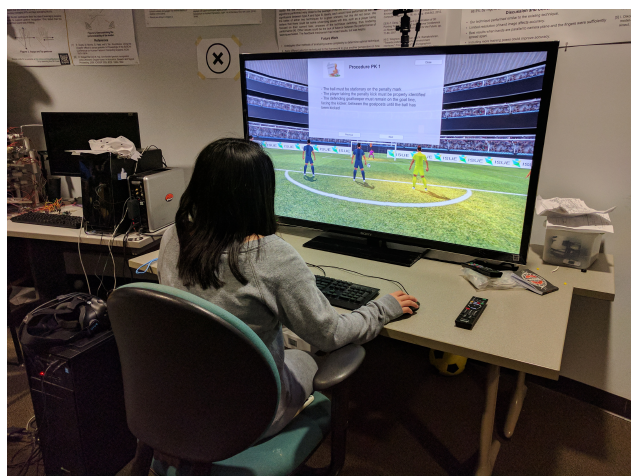
Figure 5. A user from the desktop group is performing the experiment, currently at Penalty Kick